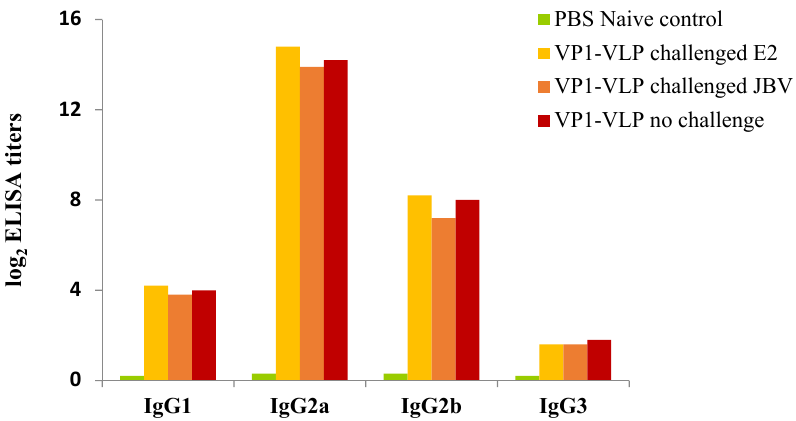
Figure 5. Antibody subtyping. Isotypes of the specific IgG antibodies in serum of the three VP1-VLP immunized groups. Sera from each mouse was obtained at day 35 post the first immunization and tested by ELISA method. PBS naïve mice group represents the control group.